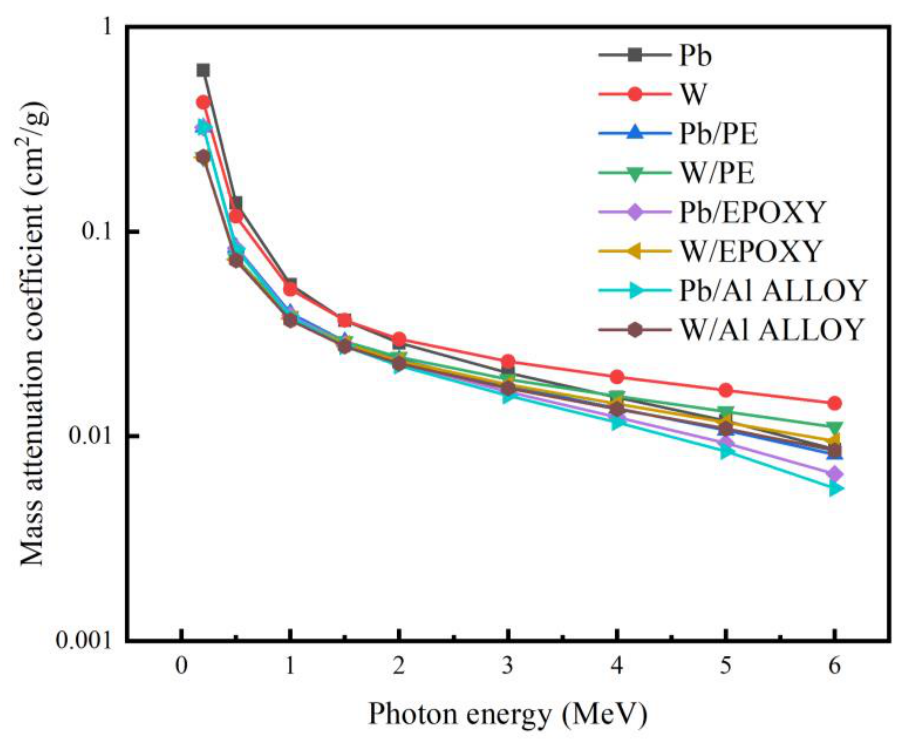
Figure 7. Mass attenuation coefficients of Pb, Wu functional fillers at 0.2 MeV–6 MeV gamma photon energies.